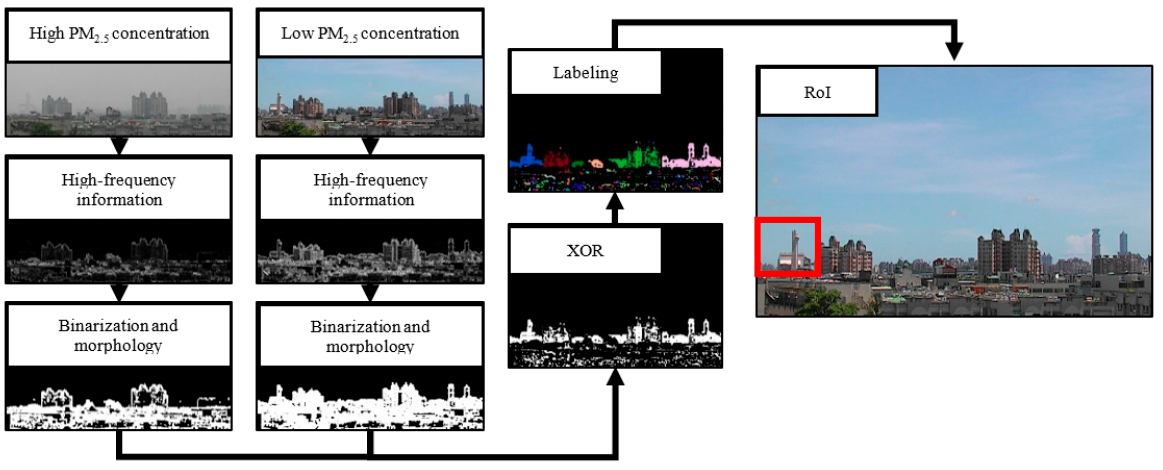
Figure 2. Automatic selection of the RoI flowchart.